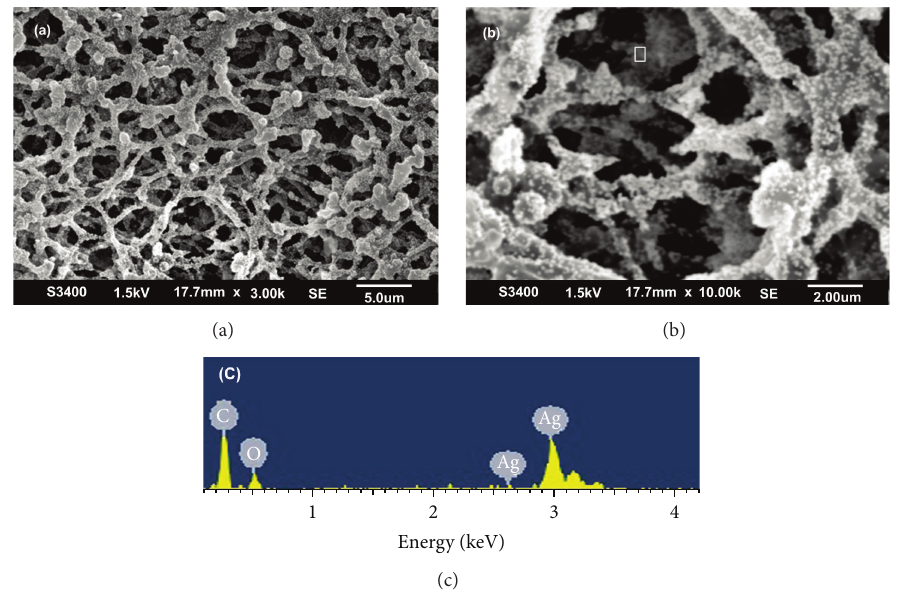
Figure 3: Representative scanning electron microscopy images of the membrane: (a) silver nanoparticles reduced membrane; (b) magnification of (a); (c) X-ray energy dispersive spectroscopy of the rectangle in (b).